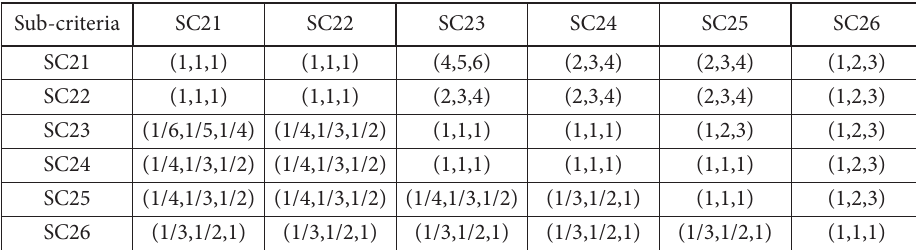
Table 5. Fuzzy comparison matrix for sub-criteria of